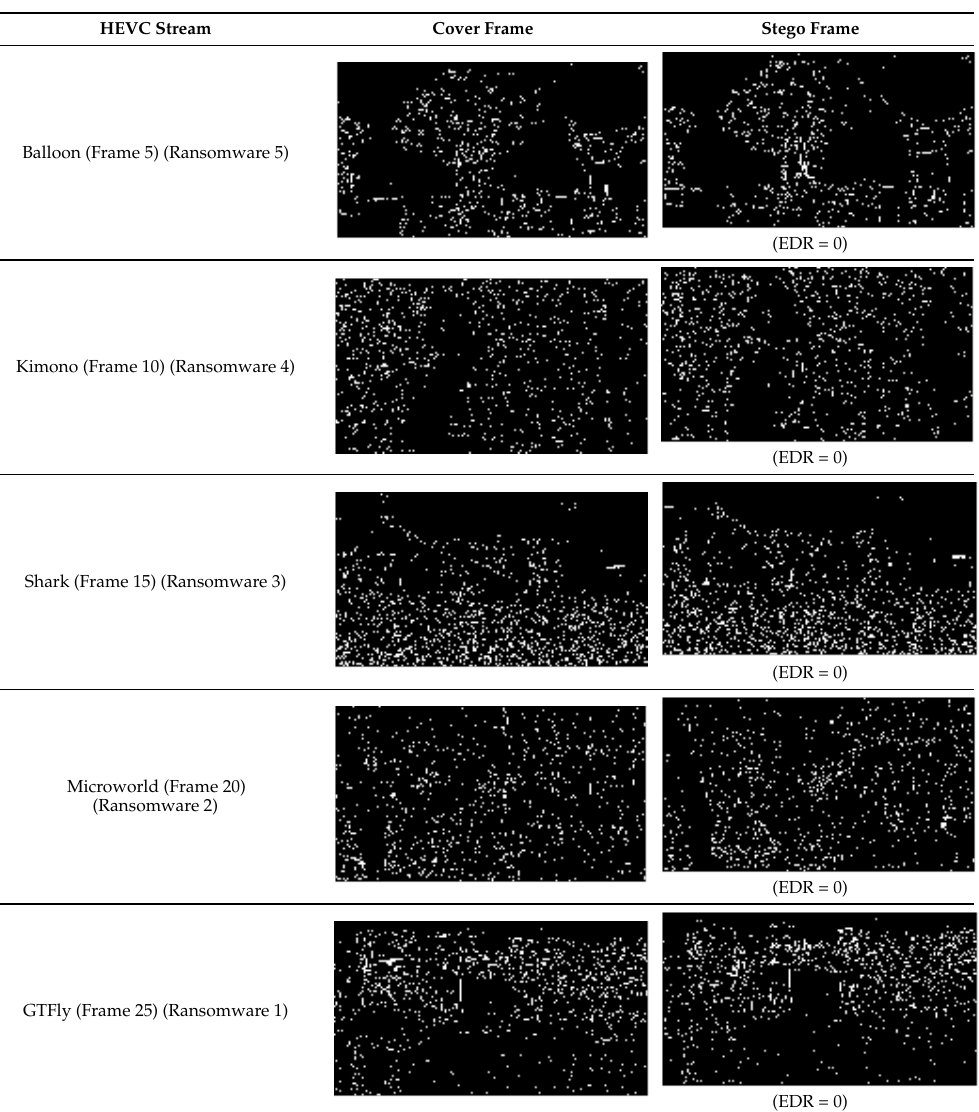
Table 6. Gaussian Laplacian edges of the tested cover and stego HEVC frames in case of using different ransomware